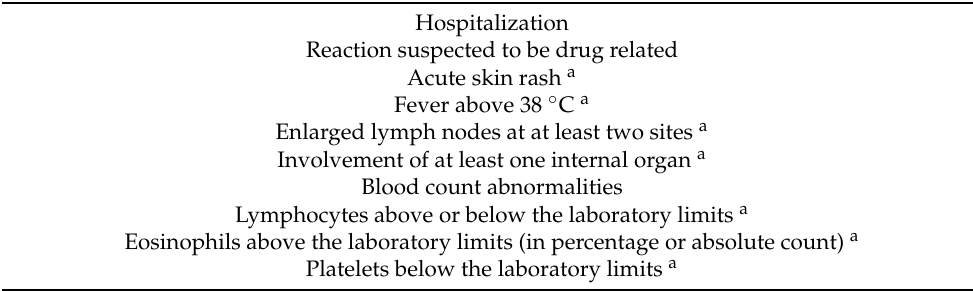
Table 2. Inclusion criteria for potential case of HSS/DRESS in RegiSCAR